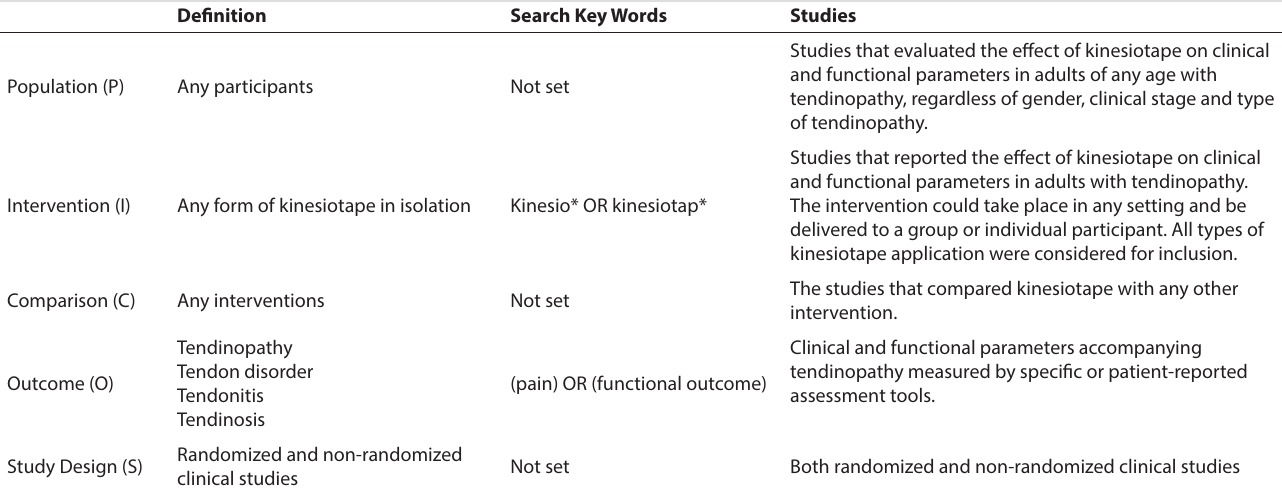
TABLE 1. PICOS format and search key words